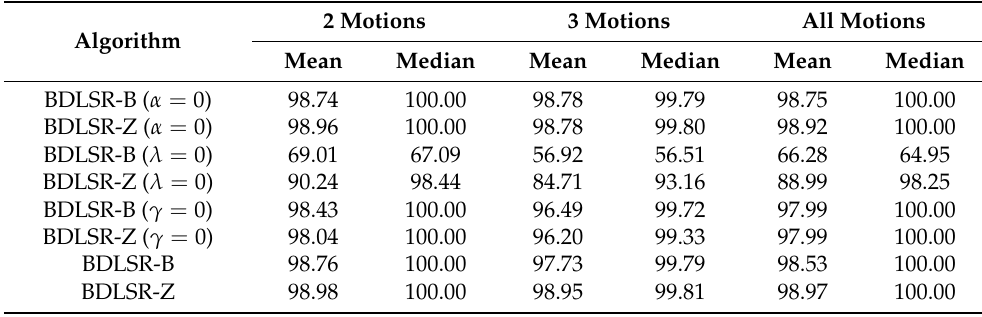
Table 7. A comparison of the accuracy (%) results when using the Hopkins 155 dataset with 4k- dimensional data in the ablation studies.